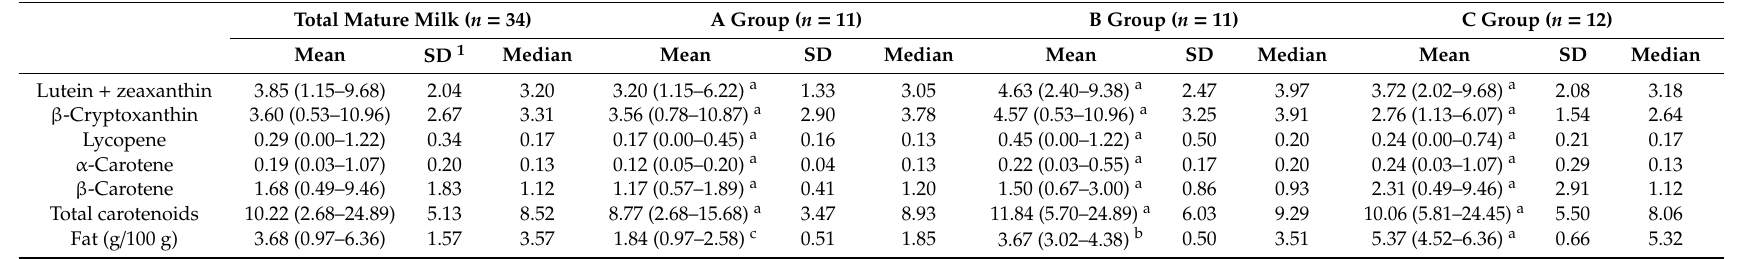
Table 1. Contents of carotenoids in human milk from mothers in Korea ( µ g / 100 g). Total Mature Milk ( n = 34)